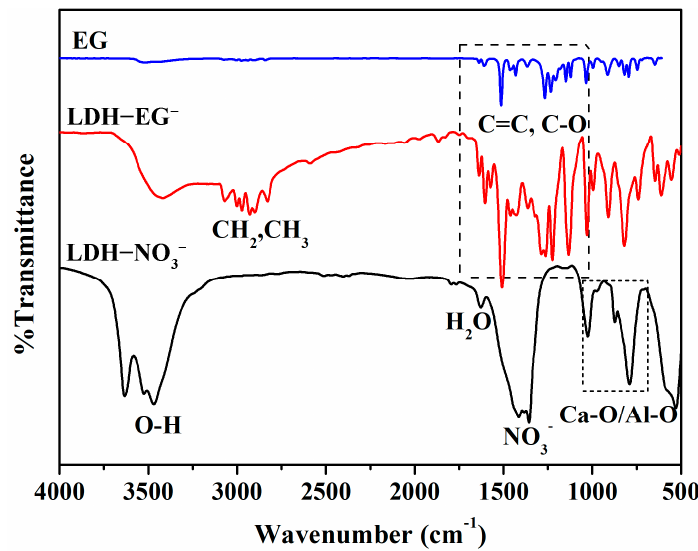
Figure 3. XRD pa tt erns of: ( a ) CaAl LDH − NO 3 − and CaAl LDH − EG − ; ( b ) The orientation diagram of EG − in the interlayer space of CaAl LDH.